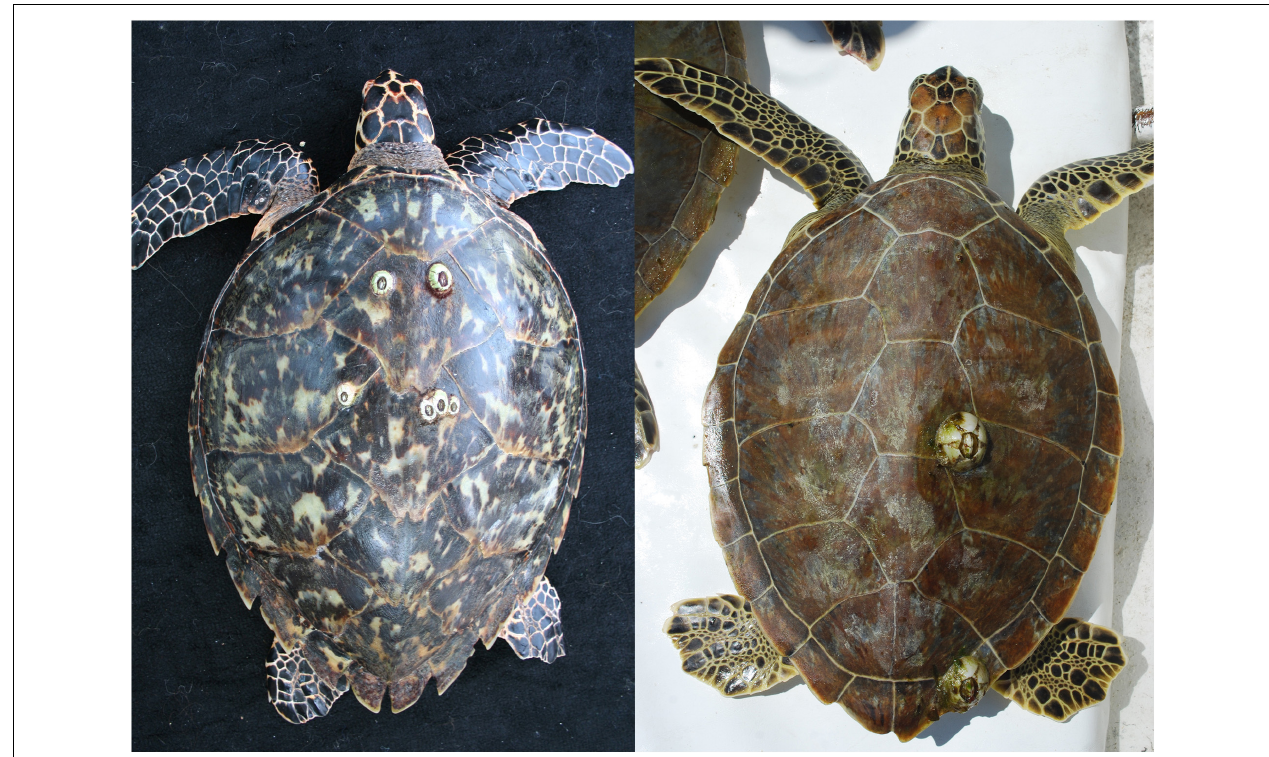
FIGURE 2 | Representative photographs of hawksbill sea turtle (left) and green sea turtle (right) from the present study with presence of barnacle species ( C. caretta and C. testudinaria , respectively).